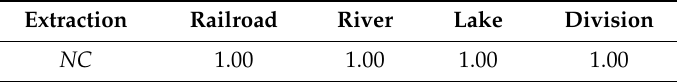
Table 2. The results of watermark extraction.